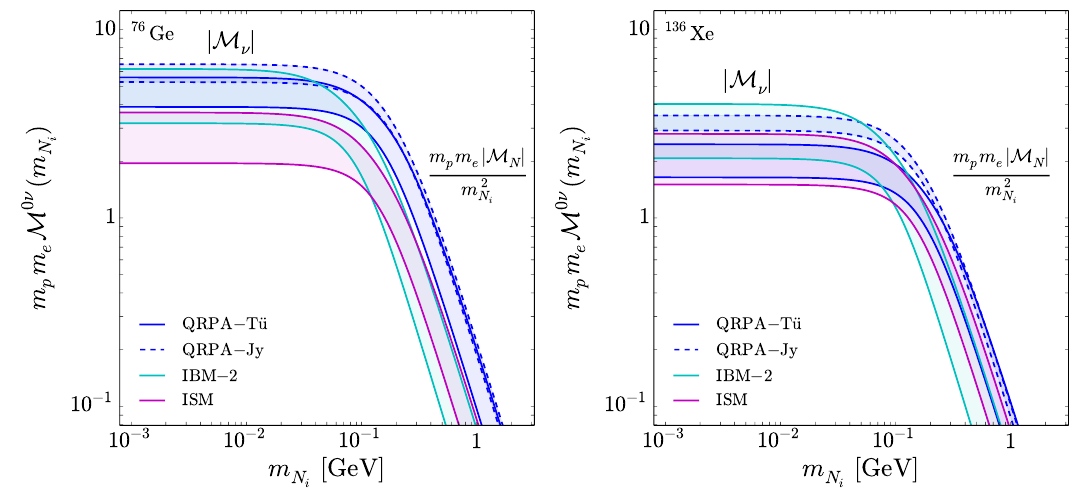
Figure 8 . Normalised 0 (cid:23)(cid:12)(cid:12) decay NMEs for 76 Ge (left) and 136 Xe (right) as a function of the exchanged sterile neutrino mass m N using the interpolating formula eq. (5.5). We make use of the i light and heavy NMEs shown in table 1. The bands indicate the NME uncertainties arising from the choice of quenched g A and short-range